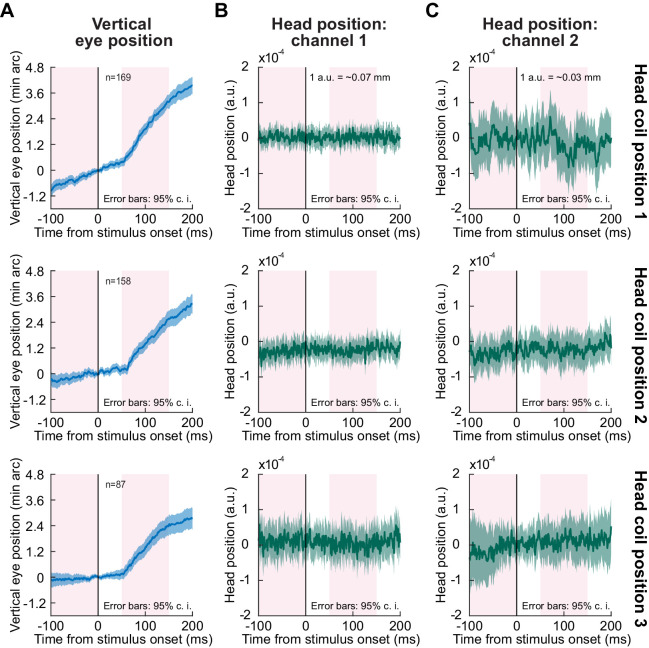
The drift response is independent of head movements.(A) Each row shows vertical eye position in a format identical to that shown in earlier figures (e.g. Figures 1 and 2). The same drift response was replicated in these three new sets of experiments of the black flash condition. (B, C) Simultaneous measurements of head position for the same sets of trials shown in (A). In each row, we placed a head coil at a different position on the monkey’s head to explore different axes of potential head movements (Methods). Each coil provided two measurements (B, C) of induced electrical current from two orthogonal magnetic fields used to measure position (these were the same two fields used to induce electrical current in the eye coil to allow measuring horizontal and vertical eye position). There was no head movement concomitant with the drift response in any of the channels. The pink intervals illustrate the measurement intervals that we used for statistical assessment of whether there was a response after stimulus onset relative to before (see text); the calibration values (in mm) were obtained using an approximate calibration of head position measurement with one of the head coil positions (Methods). Error bars denote 95% confidence intervals.